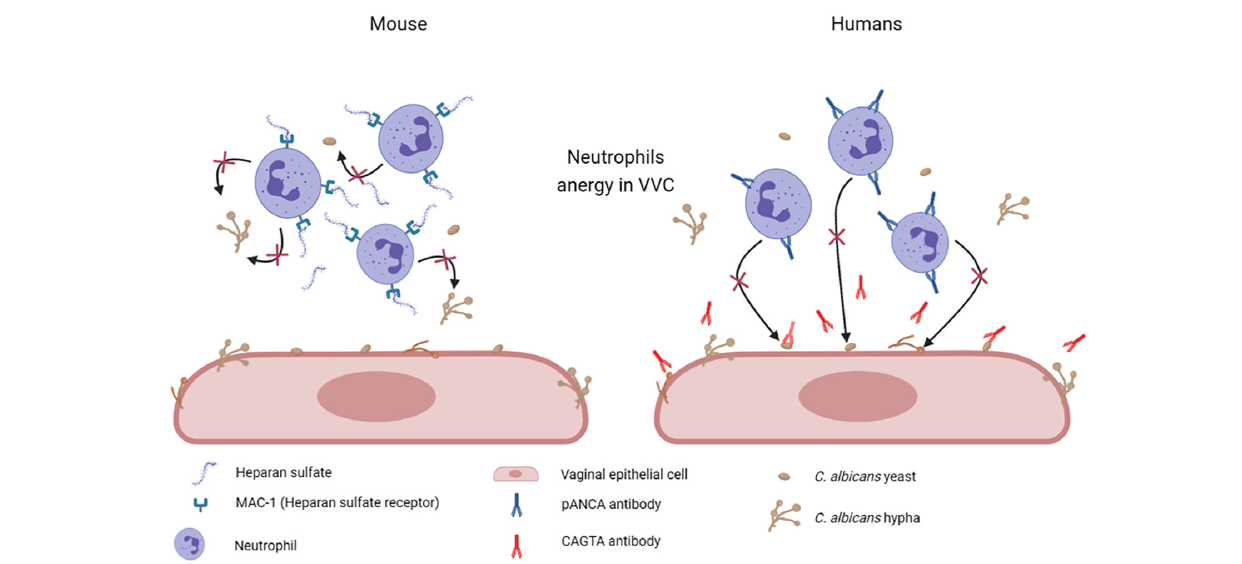
FIGURE 7 | Mechanisms of neutrophil anergy during VVC. Two different mechanisms have been hypothesized to explained neutrophils anergy during VVC. It has been demonstrated in mice that heparan sulfate saturates Mac-1 receptors on neutrophils, which are necessary for fungal recognition and neutrophils mediated killing. By our recent work we have demonstrated a significant increase in anti- C. albicans antibodies CAGTA and autoantibodies pANCA in VVC women. pANCA in particular, are associated to neutrophils and are able to block their killing activity. Both these hypotheses are consistent with the observed neutrophils anergy in VVC (Created with BioRender.com).